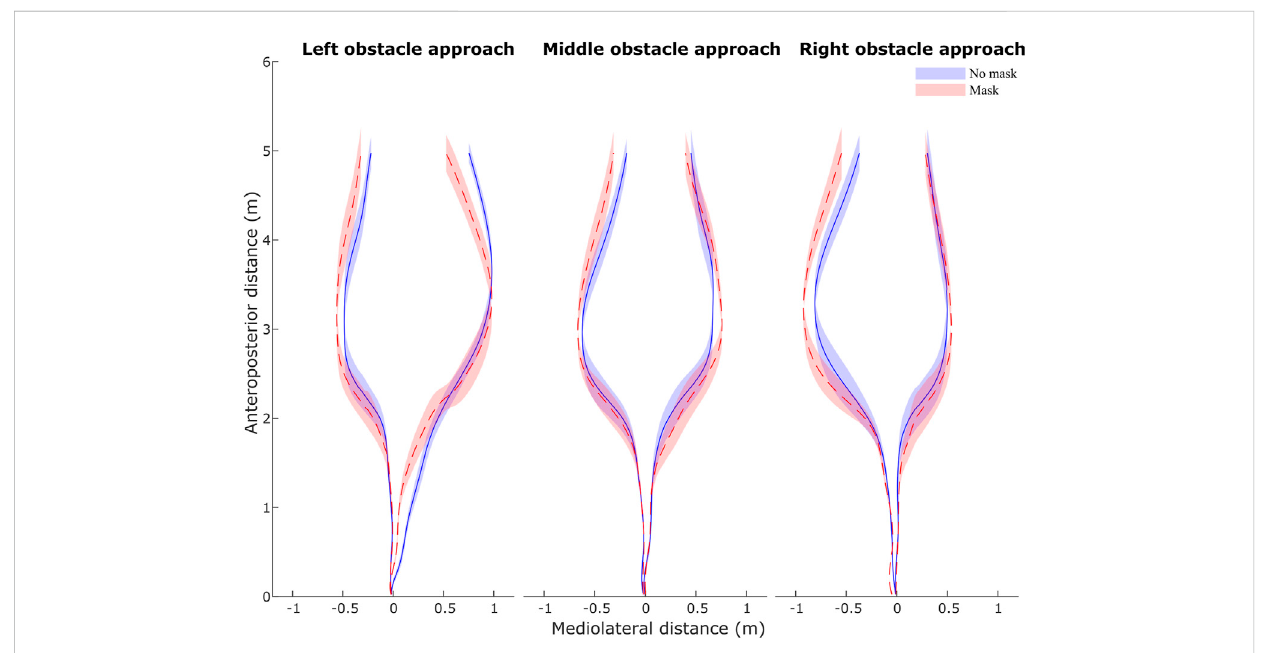
FIGURE 3 Trajectory traces for the different obstacle approach conditions. Lines represent the mean ± 1SD of all trials for all participants. Solid blue lines represent the unmasked condition and dashed red lines represent the masked